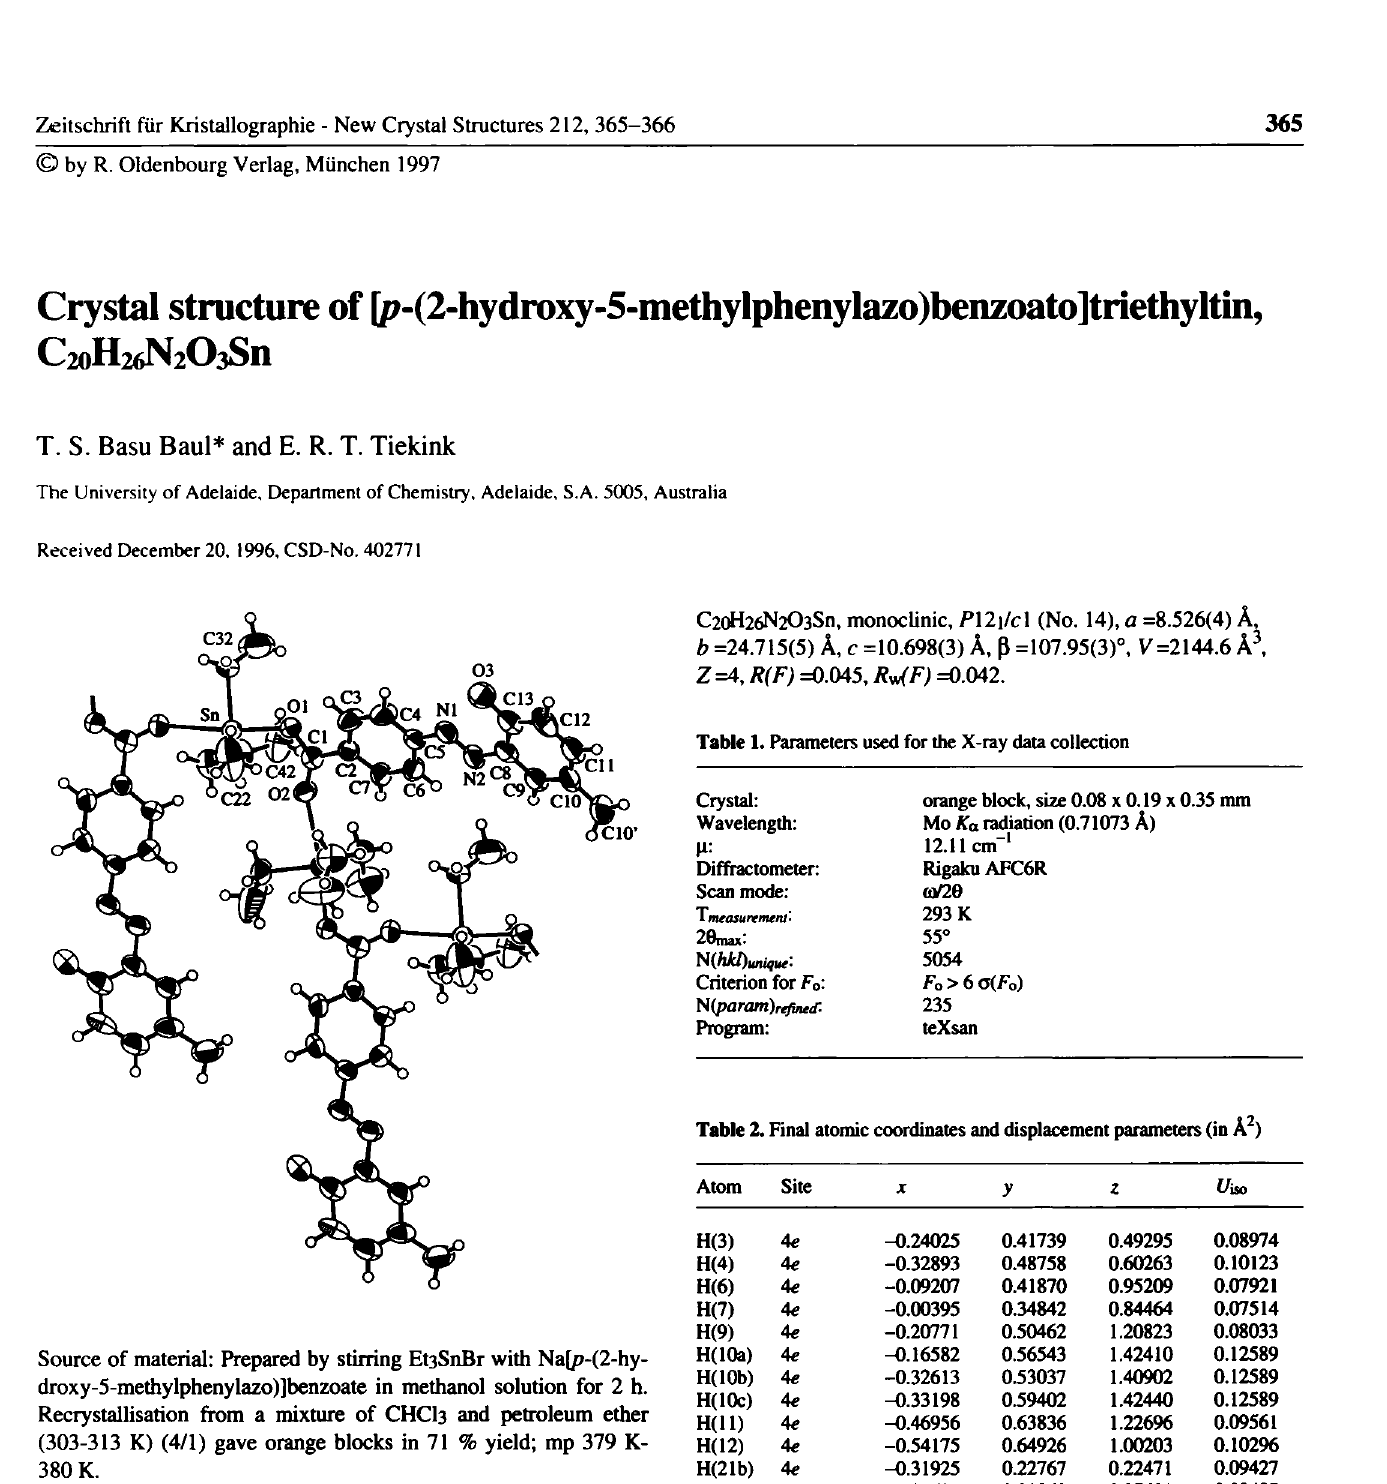
Table 2. Final atomic coordinates and displacement parameters (in Â 2